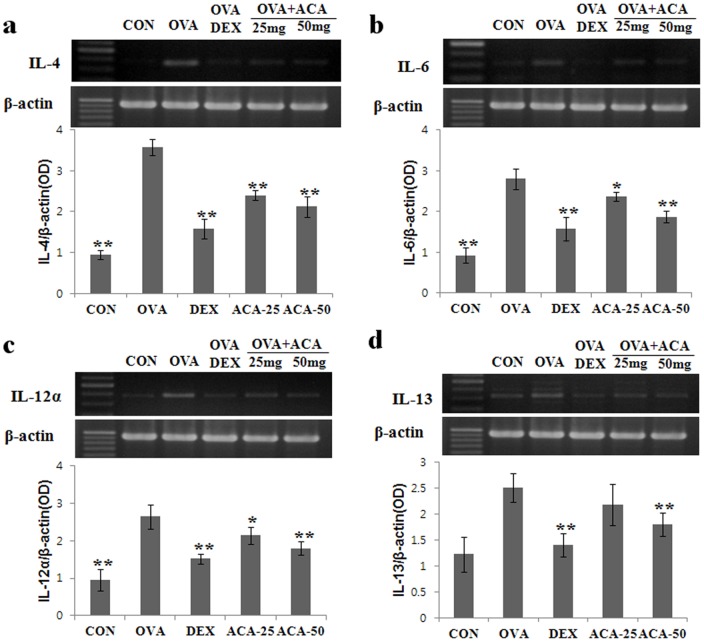
ACA dose-dependently suppressed expression of several Th1/2 cytokines in OVA-induced asthma.(a) IL-4 mRNA levels. (b) IL-6 mRNA levels. (c) IL-12α mRNA levels. (d) IL-13 mRNA levels. Results are expressed as mean ± SD (n = 6 per group). *p<0.05 and **p<0.01 vs. OVA group.